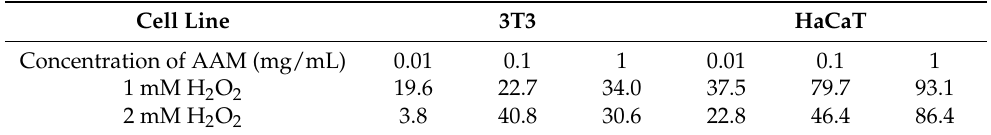
Table 4. Intracellular ∆ ROS a induced by 1 and 2 mM H 2 O 2 for 2 h respect 0 h at different concentra- tions of AAM in 3T3 and HaCaT. Cell Line 3T3 HaCaT Concentration of AAM (mg/mL) 0.01 0.1 1 0.01 0.1 1 1 mM H 2 O 2 19.6 22.7 34.0 37.5 79.7 93.1 2 mM H 2 O 2 3.8 40.8 30.6 22.8 46.4